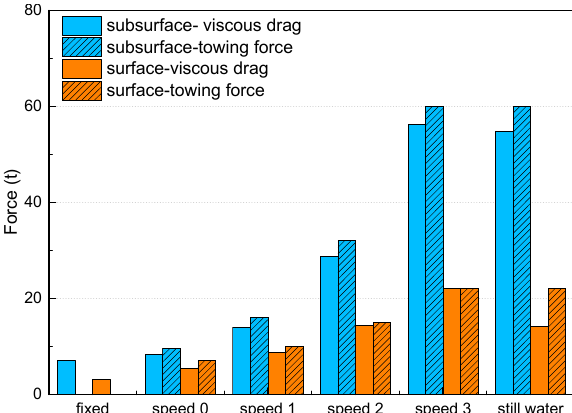
Figure 7. Comparison between the surface towing and the submerged towing under di ff erent towing speeds in terms of the viscous drag force and the towing